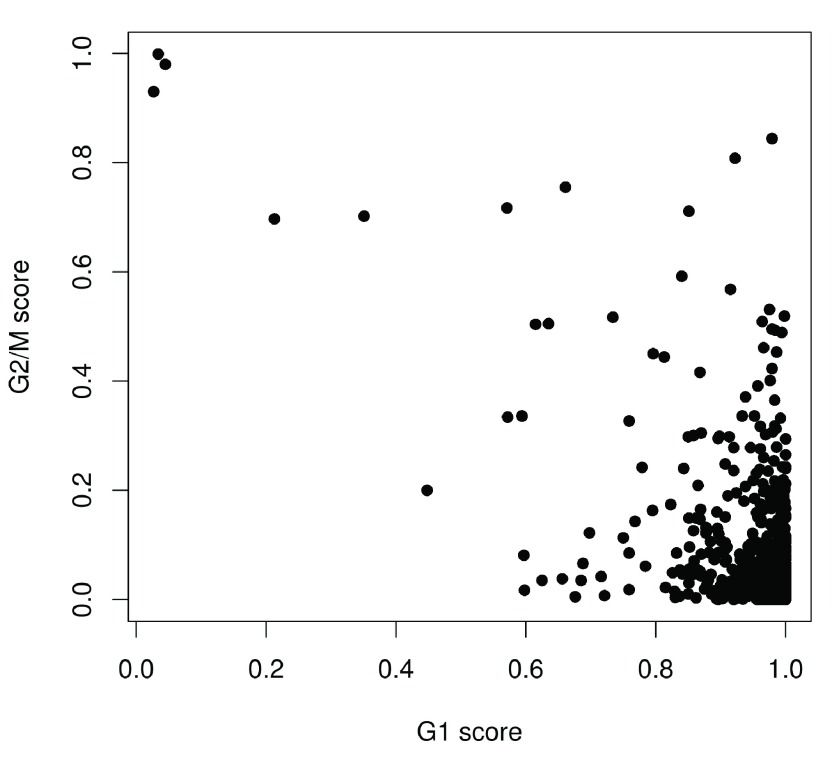
Cell cycle phase scores from applying the pair-based classifier on the brain dataset, where each point represents a cell.